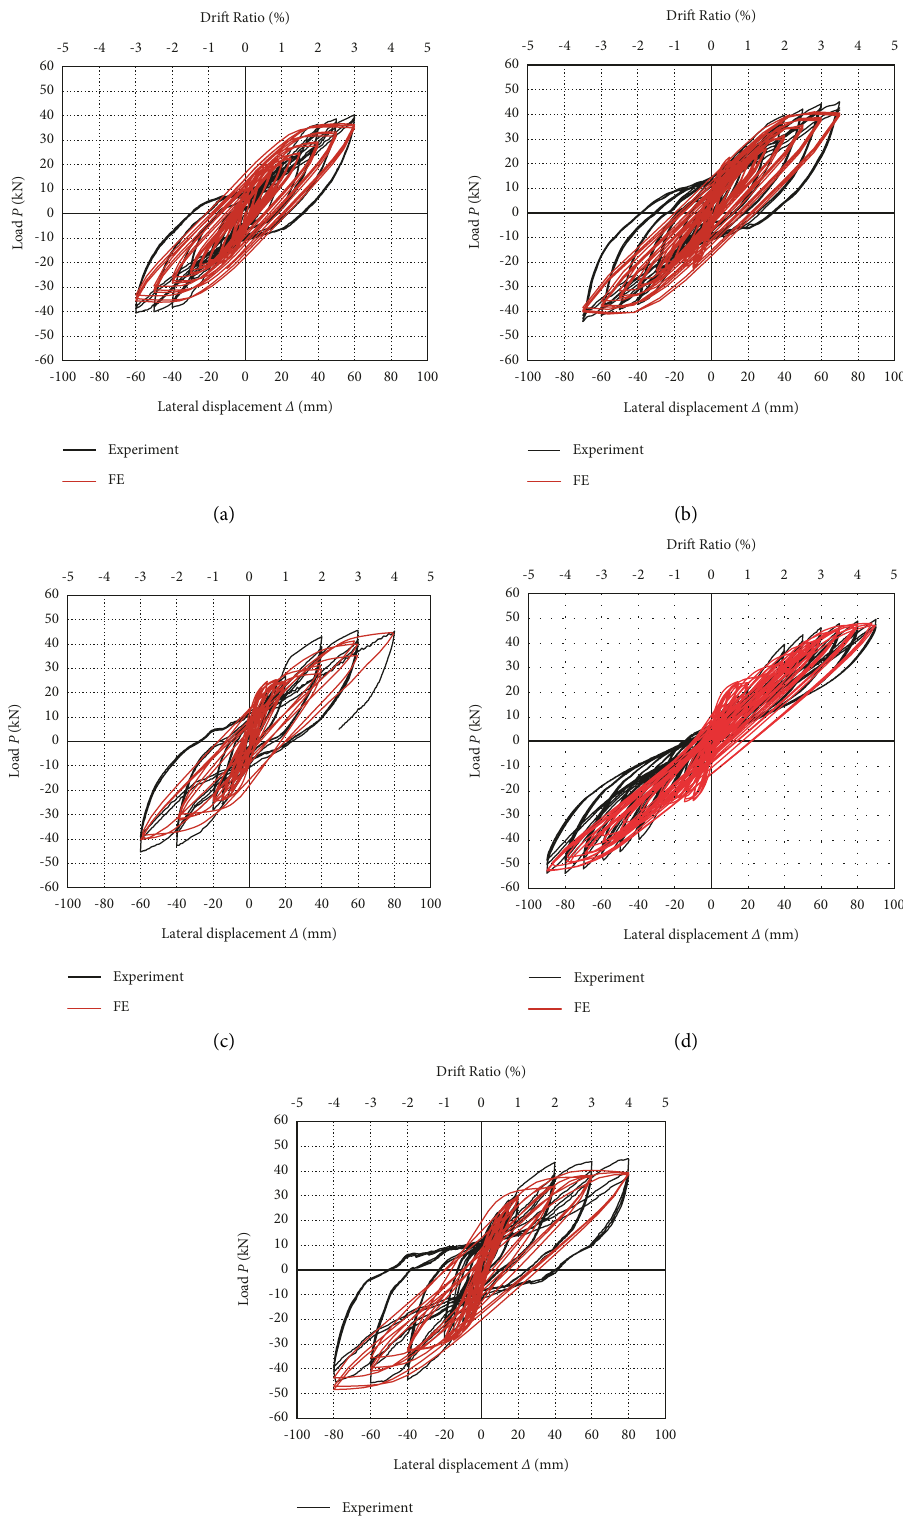
Figure 12: Comparison between numerical and test results. (a) EBCJ1. (b) EBCJ2. (c) EBCSJ1. (d) EBCSJ2. (e)